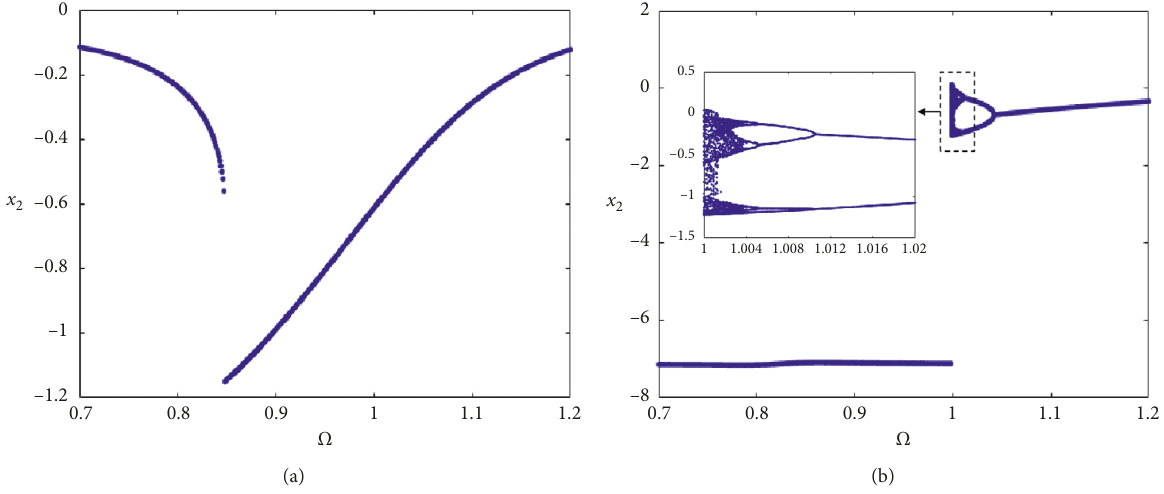
Figure 12: Cross sections of the three-dimensional bifurcation diagram for n � 2.333: (a) Y � 0.3178; (b) Y �